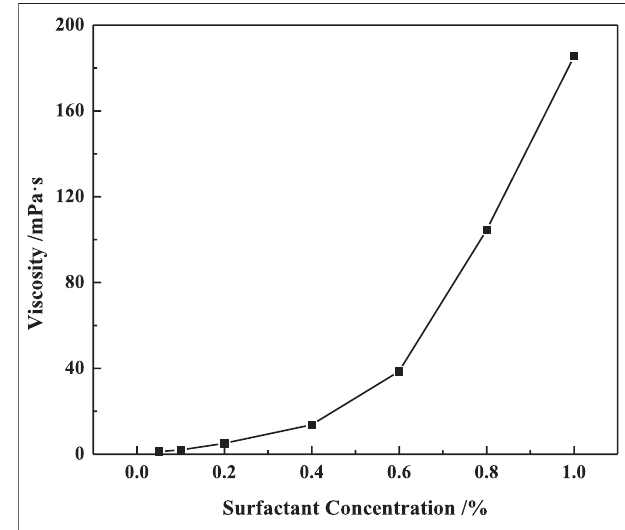
FIGURE 3 | Effect of surfactants concentration on apparent viscosity (LBA:SDS (cid:2) 3:1, T (cid:2) 50 ° C, w (NaCl) (cid:2) 4%, γ (cid:2) 7.34s − 1 ).